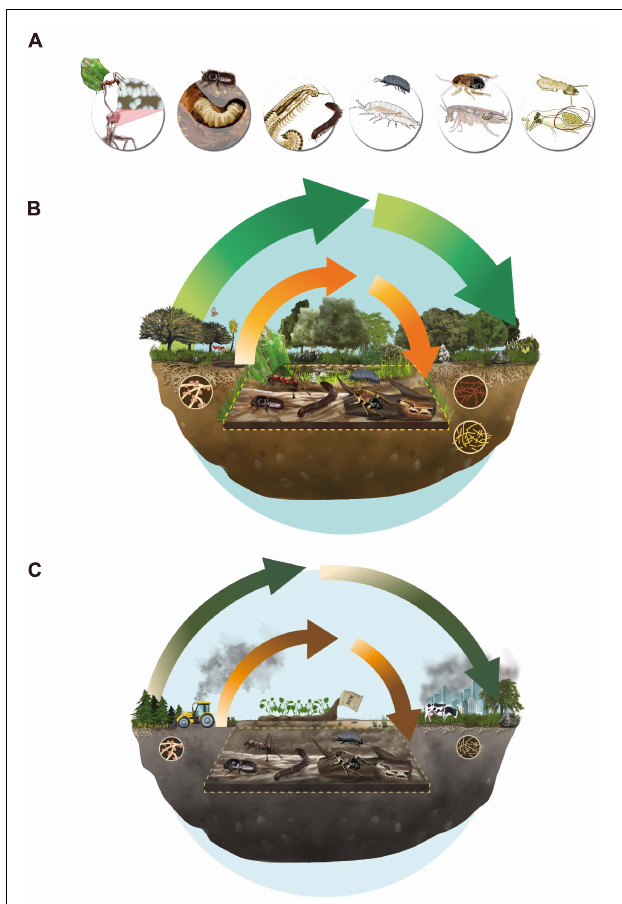
FIGURE 2 | Emergent properties. (A) Examples of arthropods comprising Ecosystem Holobionts (EH) in conjunction with their associated microbiological bionts, from left to right: (i) ants, (ii) bark beetle, (iii) millipedes, (iv) woodlice, (v) cockroaches, and (vi) termites. These animal-microorganism associations are also represented in two contrasting scenarios: an undisturbed ecosystem (B) and a human-altered ecosystem (C) . For (B,C) green arrows show nutrient cycles produced by the action of free-living microorganisms, and orange arrows the cycles in which EHs participate (within the dotted line). Arrows width illustrates the degree of anthropogenic disturbances impacting nutrient cycling processes, with thinner lines indicating greater degree of